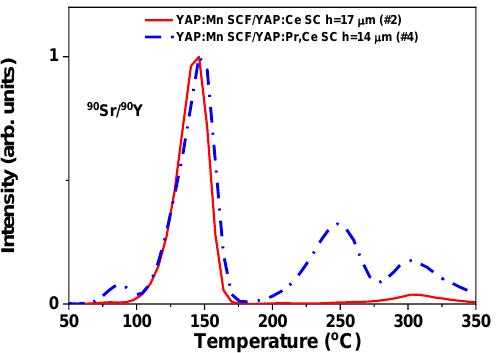
Figure 9. TL glow curves of YAP:Mn SCF/YAP:Ce SC and YAP:Mn SCF/YAP:Pr,Ce SC epitaxial structures under excitation with 90 Sr/ 90 Y β -particles.